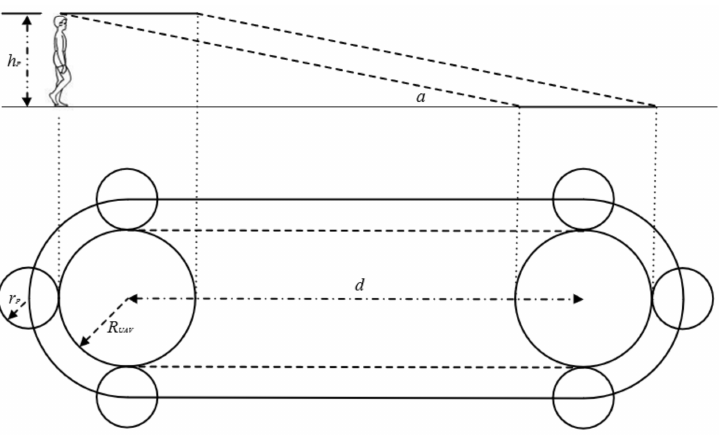
Figure 3. Casualty area caused by horizontal